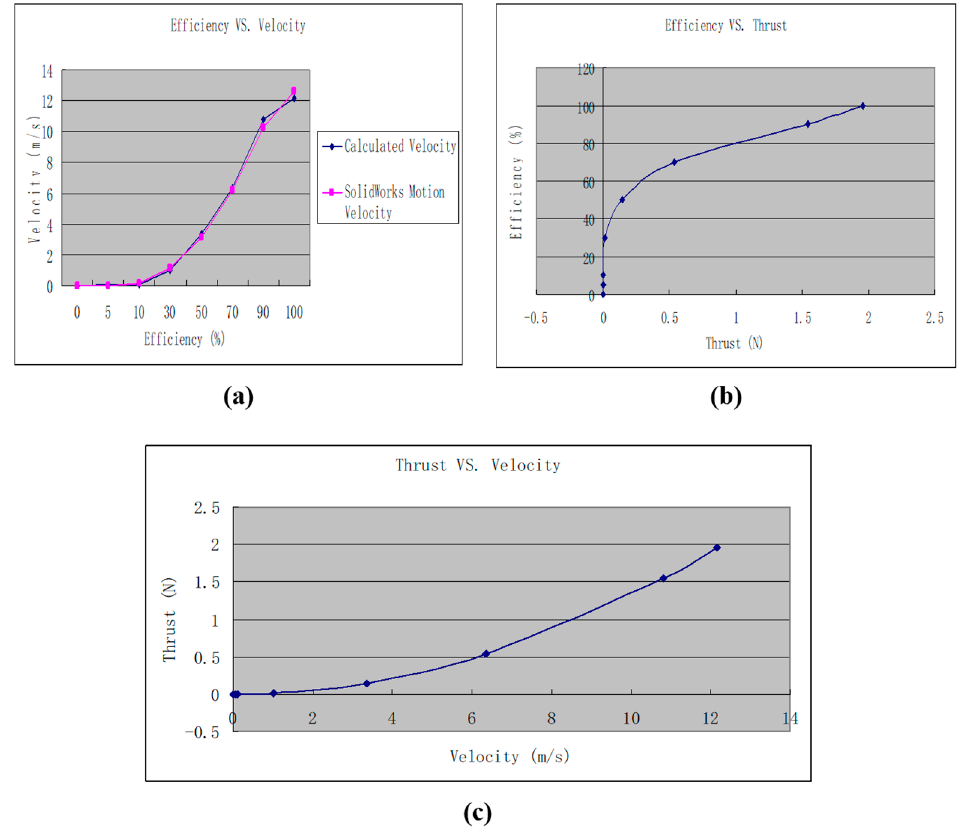
Figure 4. ( a ) E ffi ciency vs. Velocity; ( b ) E ffi ciency vs. Thrust; ( c ) Thrust vs. Figure 4. ( a ) Efficiency vs. Velocity; ( b ) Efficiency vs. Thrust; ( c ) Thrust vs. Velocity.